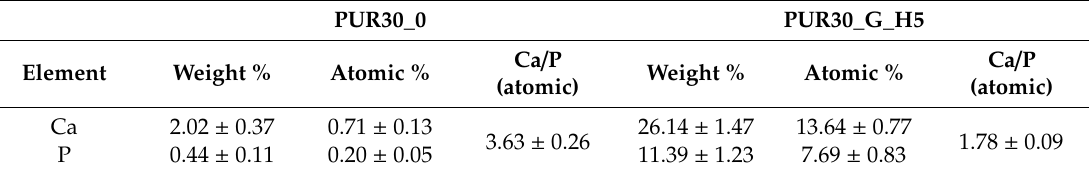
Table 4. Weight and atomic content of Ca and P in PUR_30_0 and PUR_30_G_H5 after calcification.